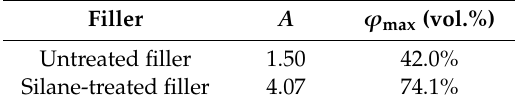
Figure 10. Thermal conductivity of composites with fillers treated with silane. The lines show the results of model calculations. Table 2. Lewis-Nielsen model parameters of the plots shown in Figures 8 and